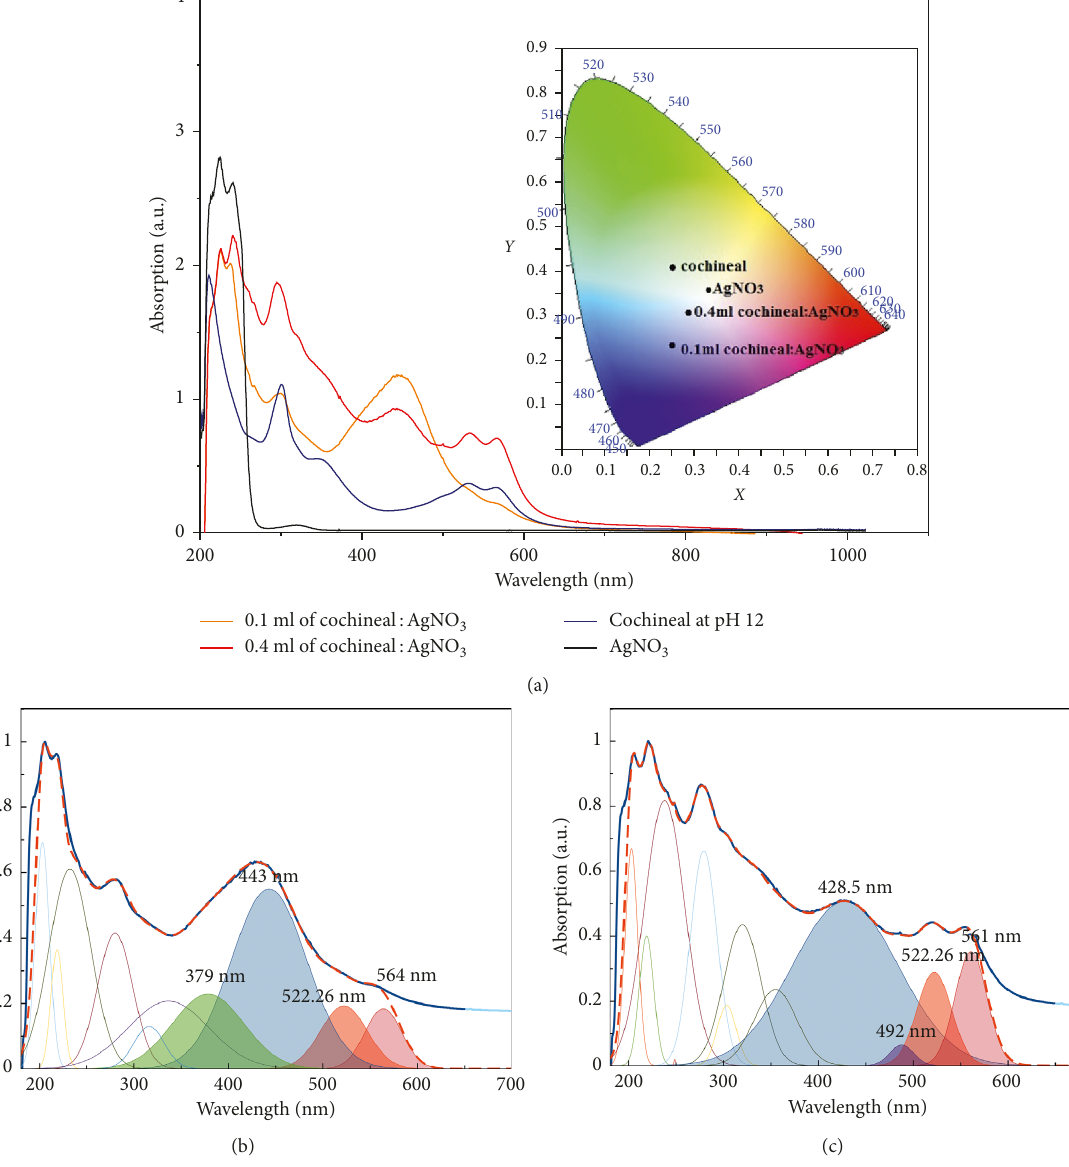
Figure 3: (a) Comparison of UV-Vis spectra of cochineal pigment (pH 12.0), silver nitrate, and AgNPs synthesized from (b) 0.1ml and (c) 0.4ml of the cochineal extract. The inset in (a) shows the corresponding CIE chromaticity diagram: cochineal pigment (pH 12.0, x 0.251, y 0.406), AgNPs (0.1ml of the cochineal extract, x (cid:31) (cid:31) y 0.315). Linear least-squares models (dashed red lines) of UV-Vis spectra (solid blue lines) with Gaussian components are shown in (cid:31) (b) AgNPs (0.1 ml of the cochineal extract) and (c) AgNPs (0.4ml of the cochineal